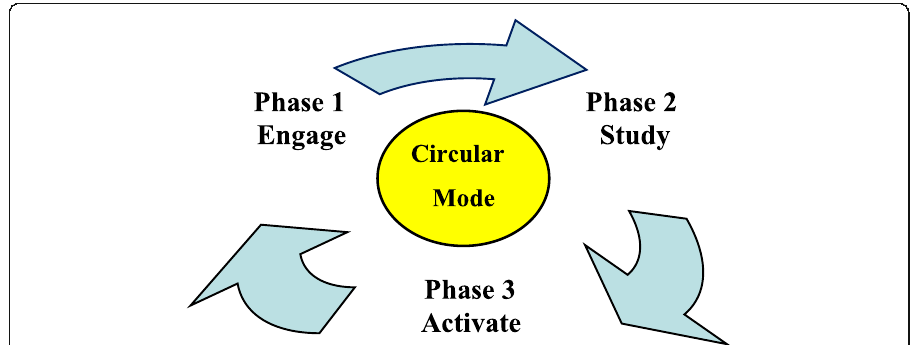
Fig. 1 A schematic representation of the three-phase teacher education program